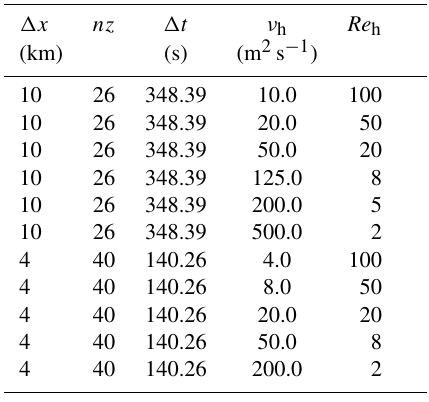
Table 2. Experimental setup for baroclinic eddy test case. Listed are the horizontal mesh resolution (min. triangle edge length), number of vertical levels, time step, horizontal viscosity, and the approxi- mate grid Reynolds